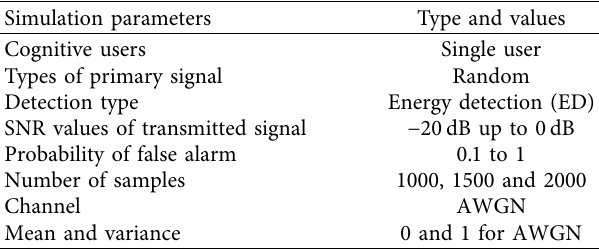
Figure 3: Block diagrams of the proposed technique of the energy detector with entropy. Table 1: Parameters used for